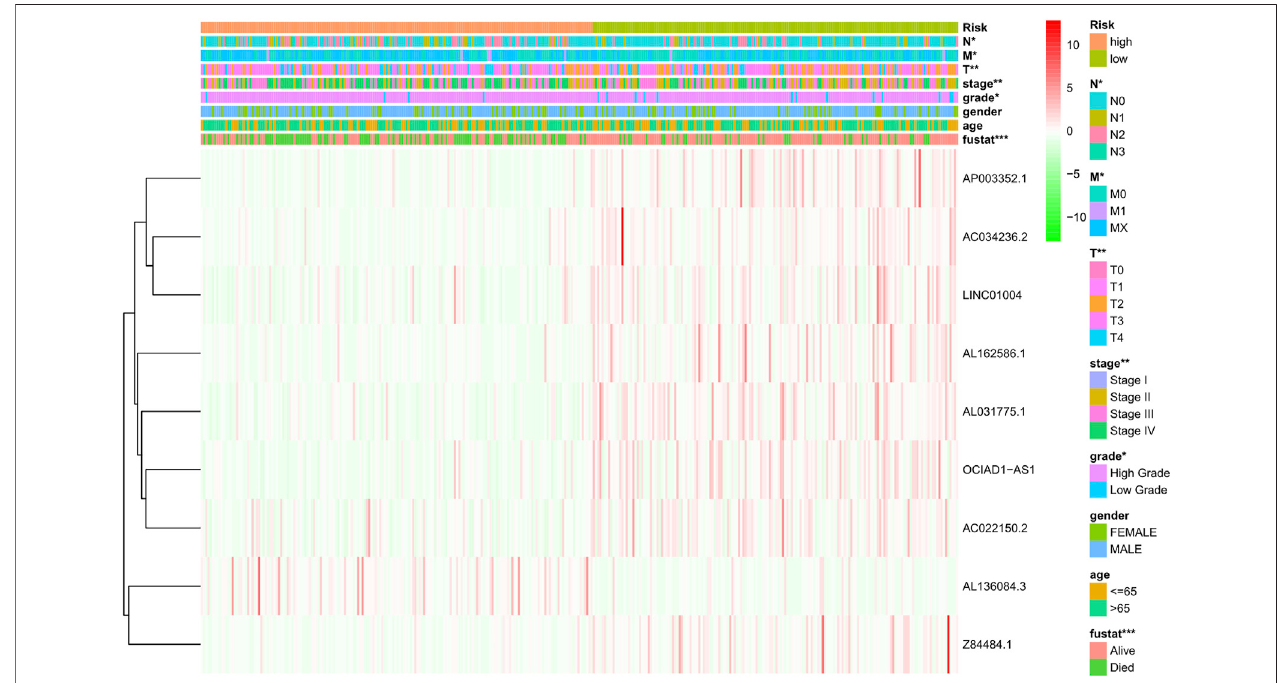
FIGURE 5 | Distribution heat map of nine prognostic ferroptosis-related lncRNAs and clinicopathological variables in the high- and low-risk groups. lncRNAs, long noncoding RNAs; N, lymph node; M, metastasis; T, tumor.